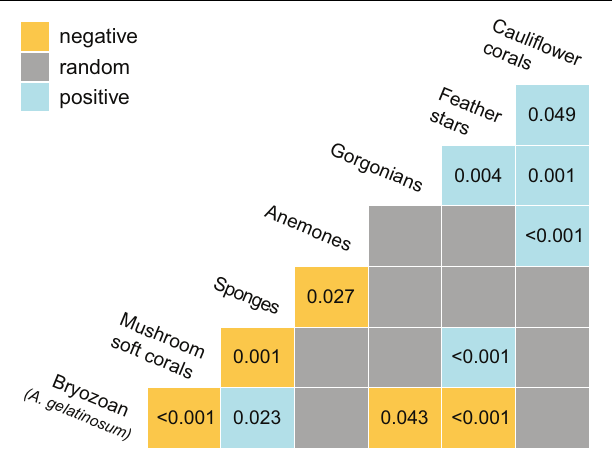
FIGURE 6 | Heat map showing the positive and negative associations between taxa as determined by a probabilistic co-occurrence model (Veech, 2013). For each pair the observed frequency of co-occurrence within images ( n = 1,239) is either, significantly large and greater than expected (positive association), significantly small and less than expected (negative association), or not significantly different and approximately equal to expected (random association). Associations are considered significant where the probability of the observed frequency of concurrence is < 0.05 were the taxa distributed independently of one another. P -values are provided for significant